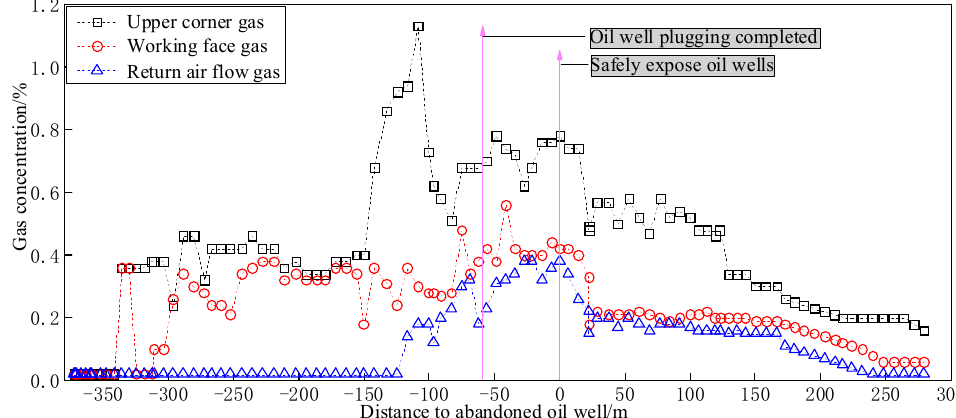
Figure 13. Gas concentration change curve during the period of the impact of the I0104 1 05 working face passing through the Ma tan 31 abandoned oil well.